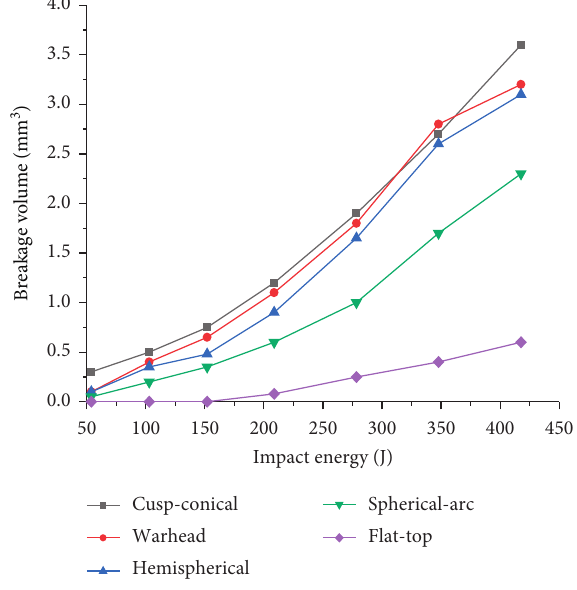
Figure 10: Rock breakage volume. Figure 11: Rock breakage